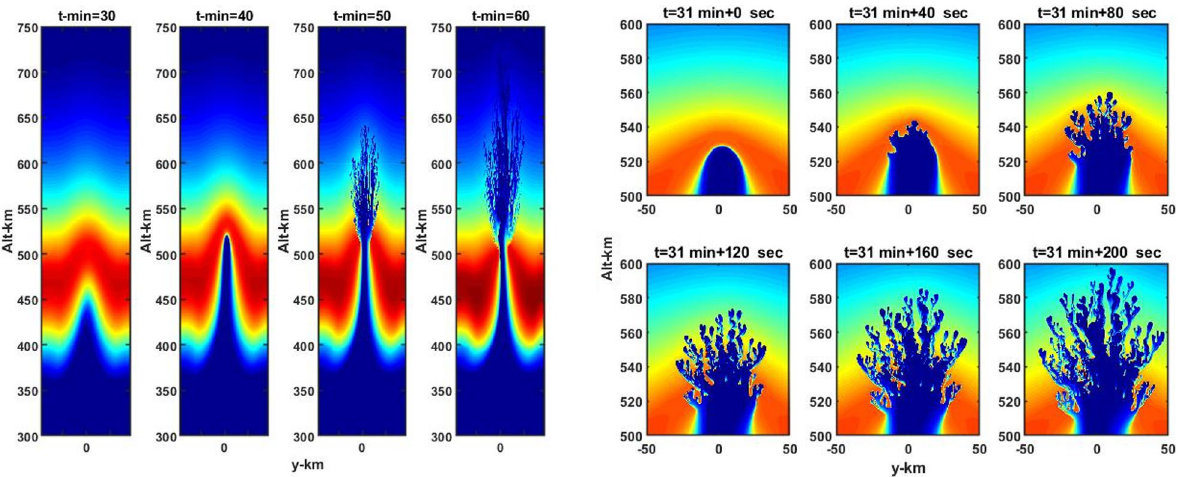
Fig. 7 Structure development summary for single-bubble realization with doubled ion density for comparison to Fig. 1